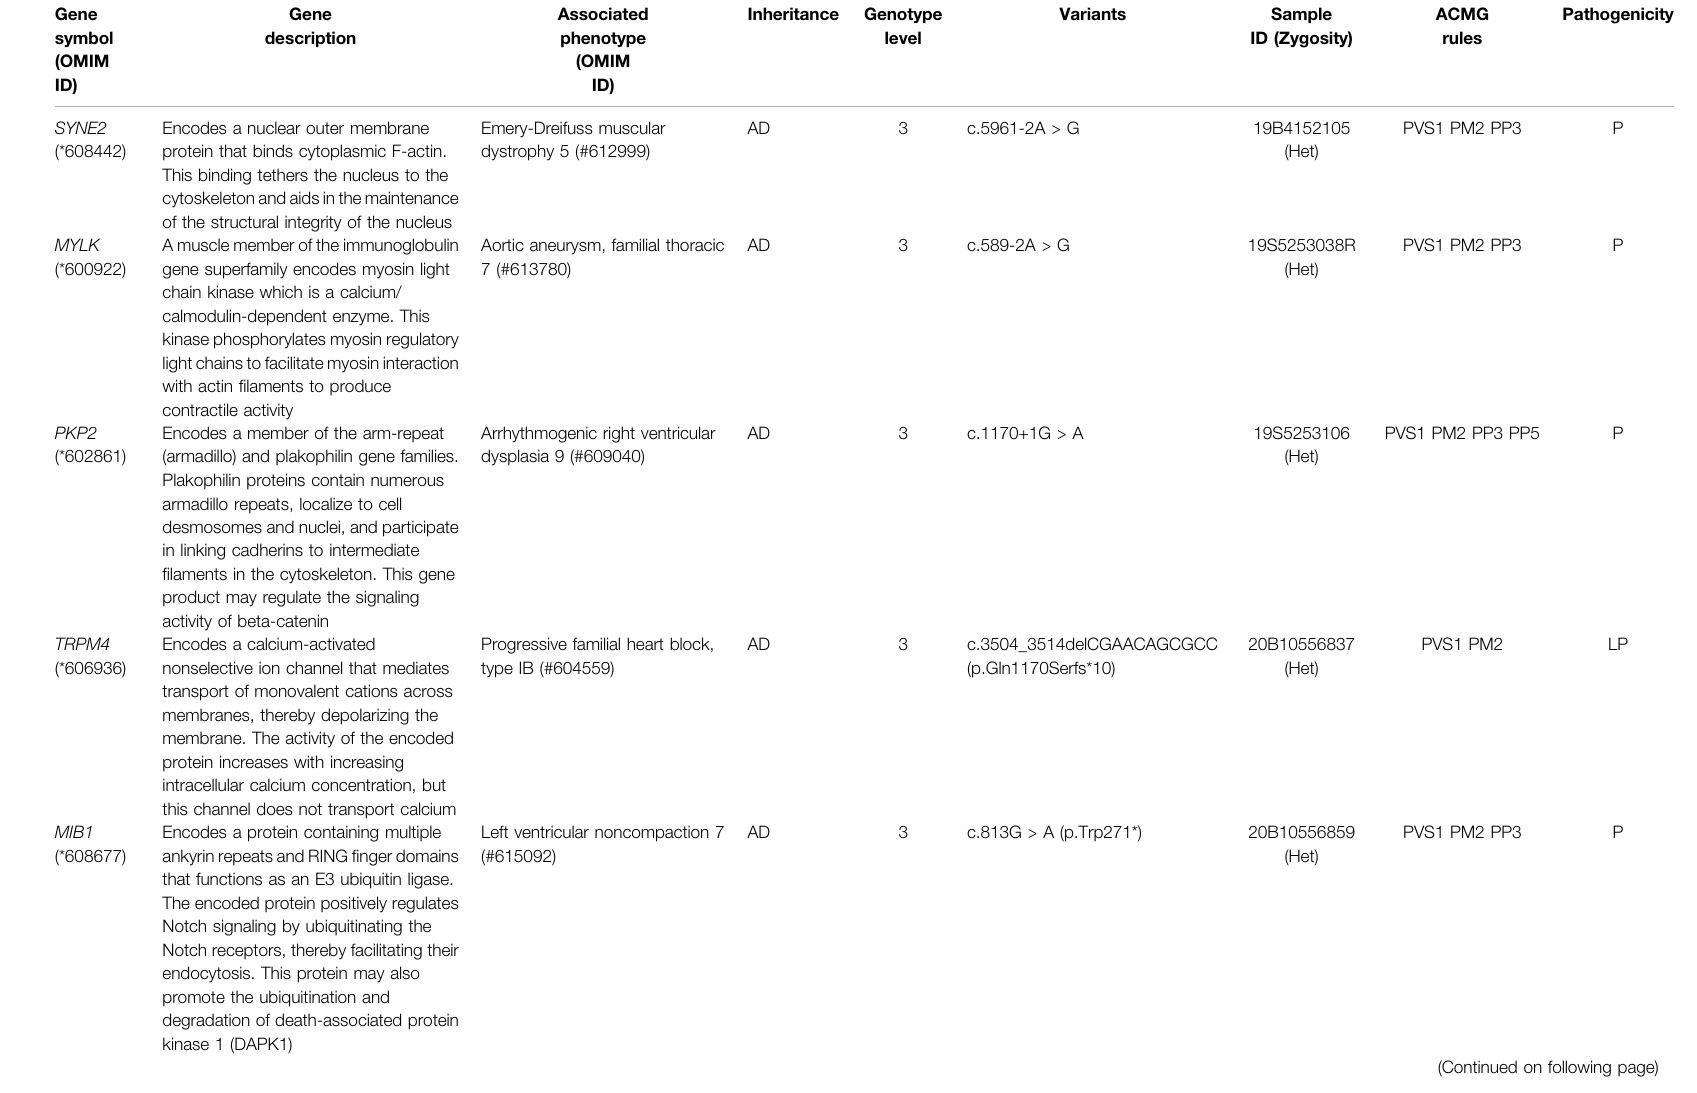
TABLE 4 | Candidate CHD-causing genes by manually in-depth interpretation of WES results. Gene symbol